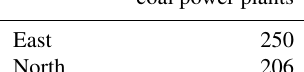
Table 3. Number of power plants in each region within China.